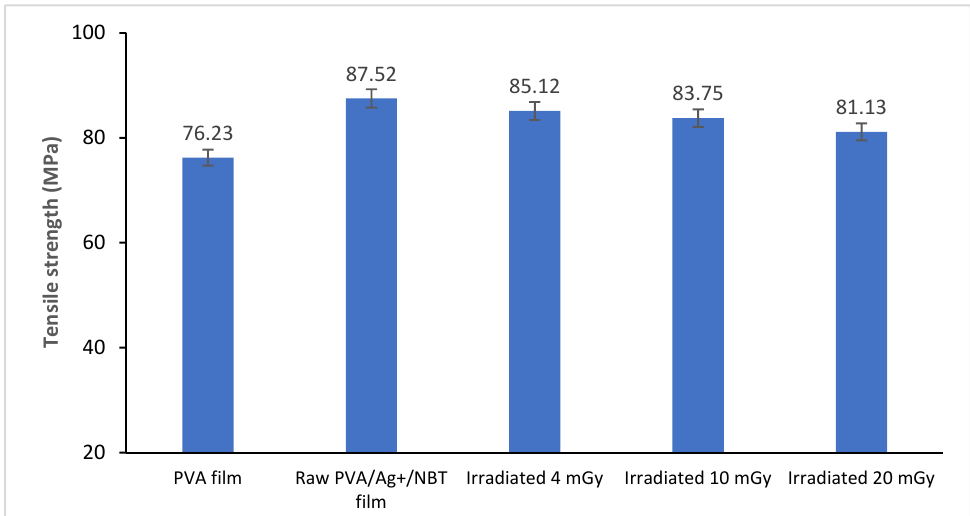
Figure 6. Tensile strength variation of raw PVA film, control and irradiated PVA/Ag + /NBT nanocom- posite films with increased X-ray